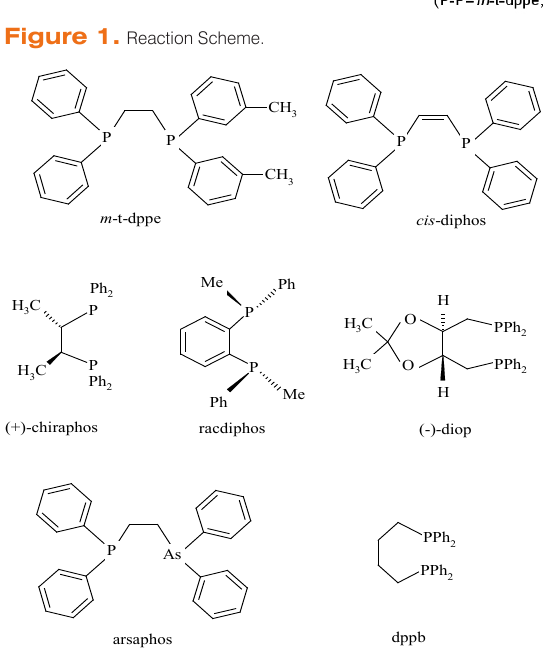
Figure 2. Structures of the chiral and achiral ditertiaryphosphine ligands.